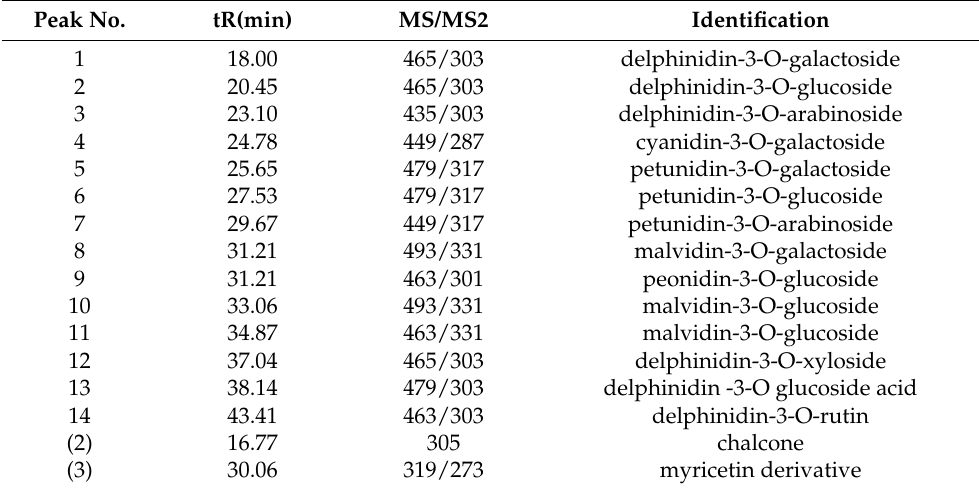
Table 2. Individual anthocyanins and their derivates in extracts and foulants. Identification based on MS and published data